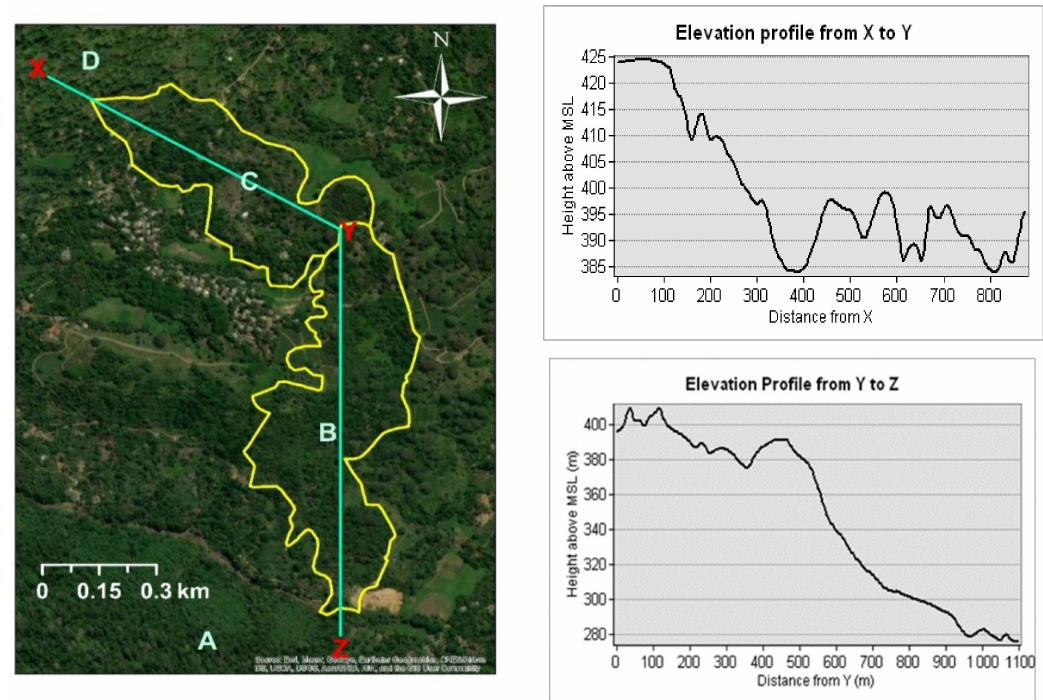
Figure A1. Elevation profiles of the upper section (from X to Y) and the lower section (from Y to Z) of thee Endane Biodiversity Corridor, Dilmah Conservation and Kahawaththa Plantations PLC, Sri